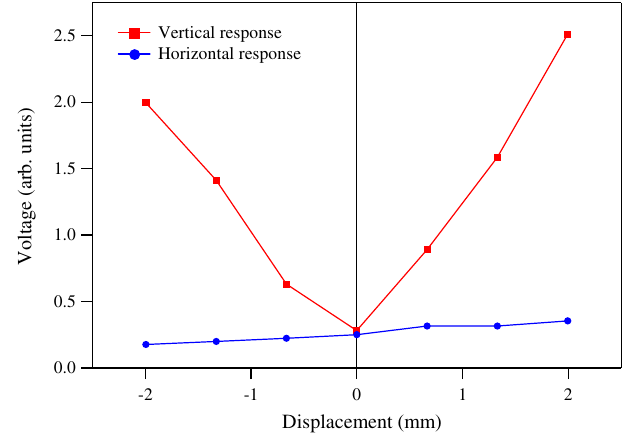
FIG. 10. (Color) Measured response of the 2106 MHz HOM due to vertical (red) and horizontal (blue) displacements through cavity 7. TABLE I. Results of beam-based measurements to determine HOM polarizations of several of the most dangerous modes. For each dipole HOM pair, the higher Q approximately